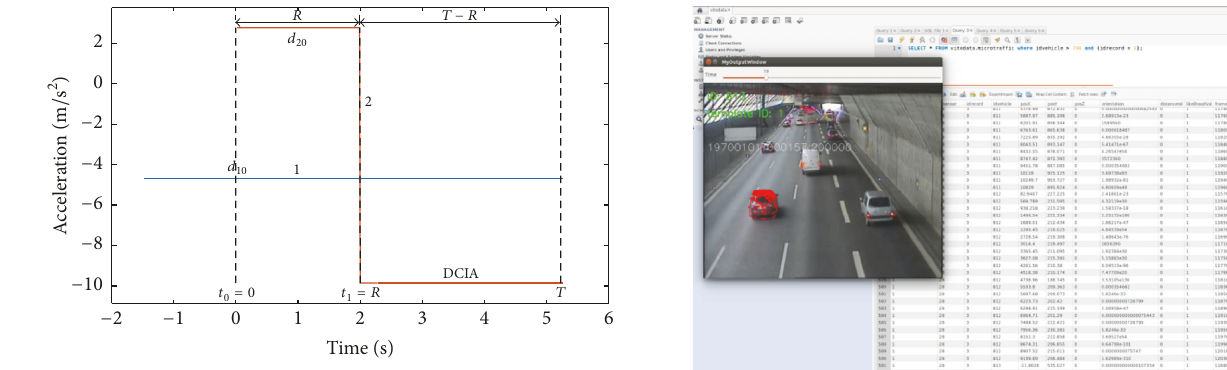
Figure 3: Acceleration-time profile for the conflict situation. The profiles are numbered with 1 and 2 for the leading and following vehicles, respectively, while 𝑑 10 and 𝑑 2 0 are the corresponding initial acceleration.